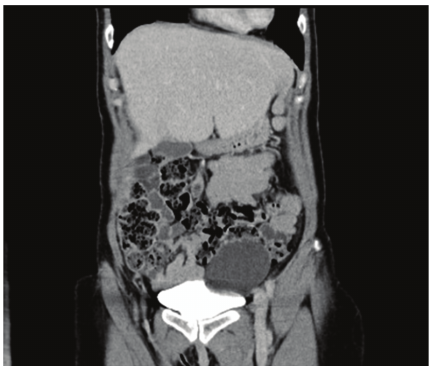
Figure 1: Coronal view of cyst showing its relationship with the sigmoid colon on computed